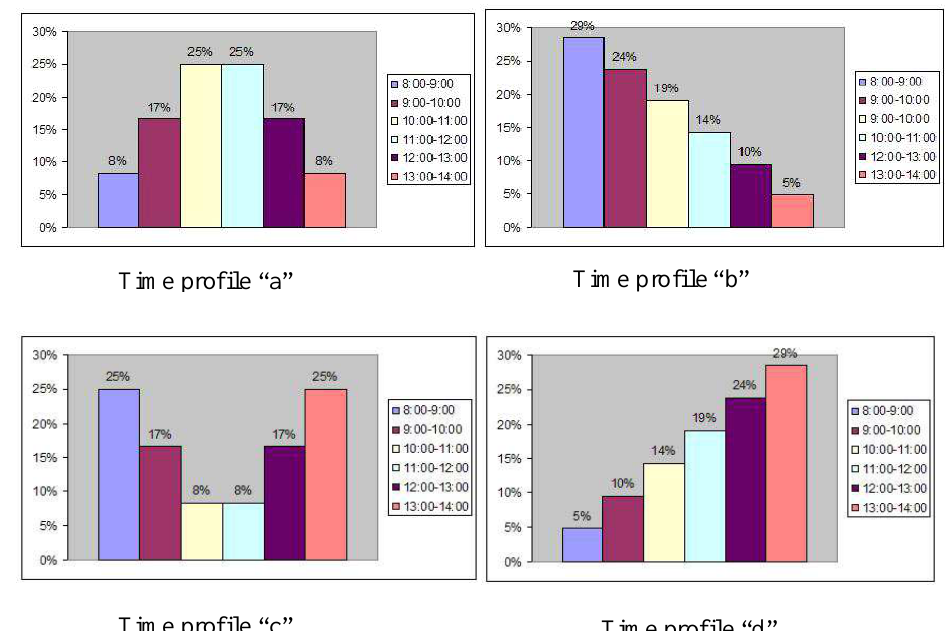
Figure 3. Four realistic cases of time profile